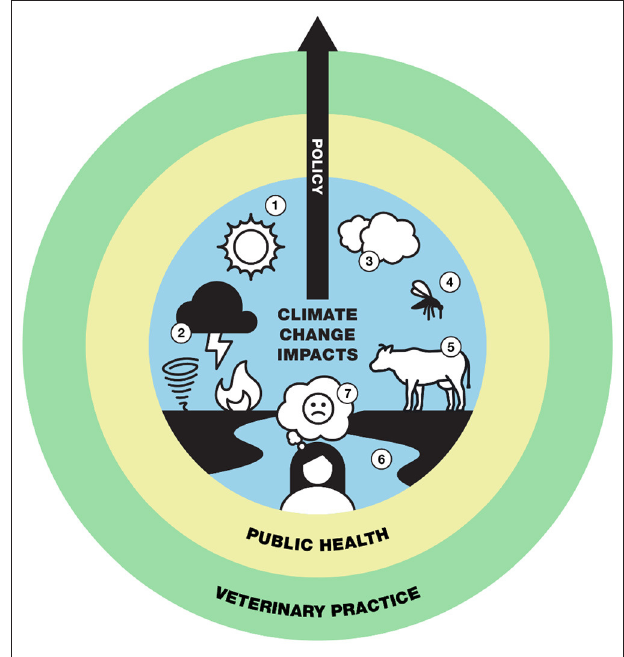
FIGURE 1 | Policies already exist which highlight issues impacted by climate and which fall within a One Health and planetary health framework. These issues include (1) increasing temperature, (2) extreme weather events, (3) air quality, (4) vector-borne disease, (5) food safety/security, (6)